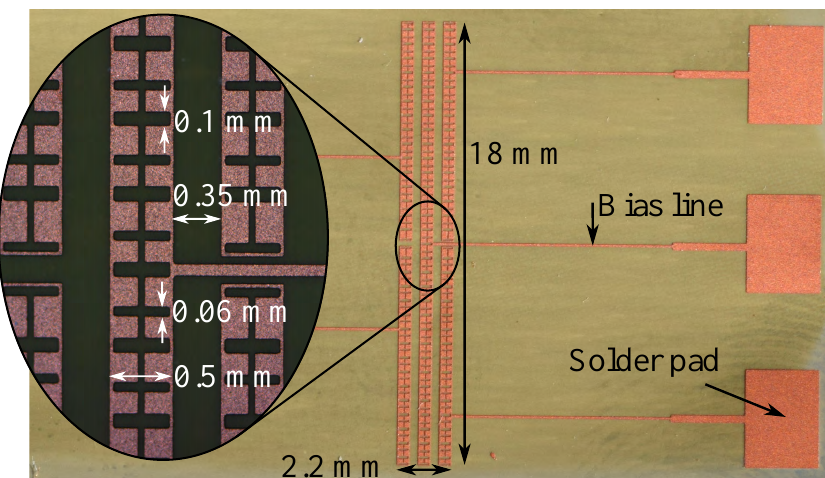
Figure 24. Photograph of the Pyralux substrate with the processed electrodes for the NRD phase shifter.